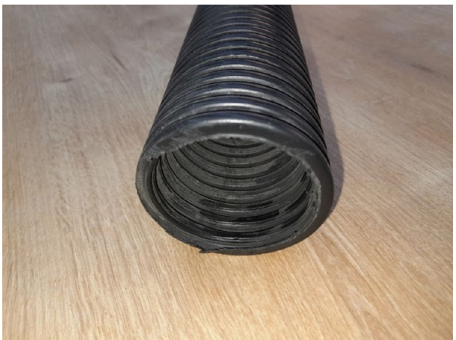
Figure 4: Strain gauge glued on the outside of